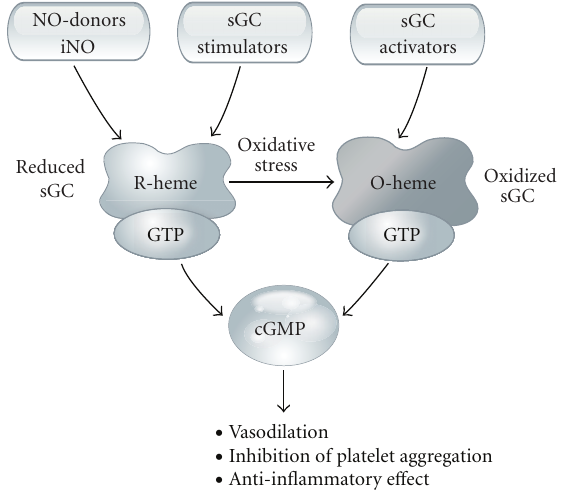
Figure 2: Role of NO (nitric oxide), inhaled NO, and sGC (soluble guanylyl cyclase) stimulators in stimulating the reduced heme of sGC and the role of sGC activators in stimulated oxidized sGC to stimulate cGMP leading to vasodilation, inhibition of platelet aggre- gation and an anti-inflammatory e ff ect in the vascular